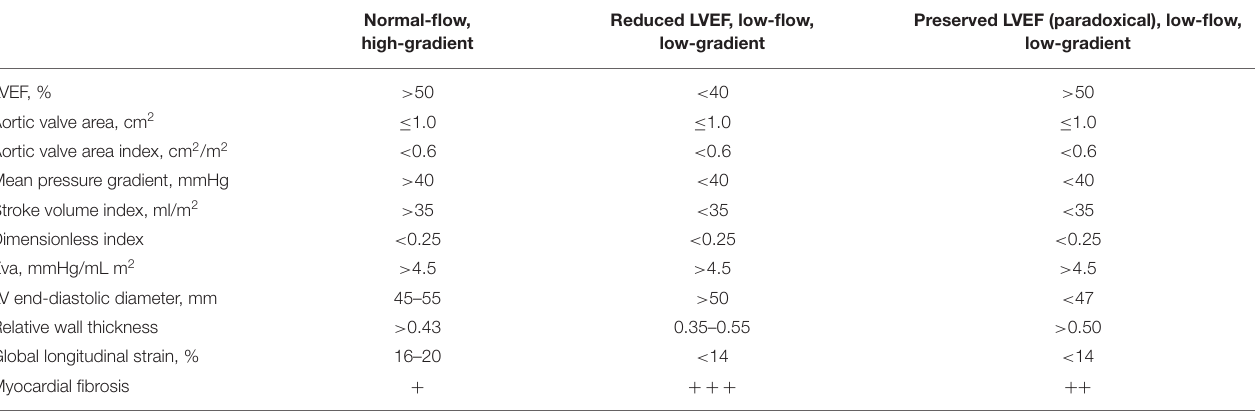
TABLE 4 | Types of severe aortic stenosis.